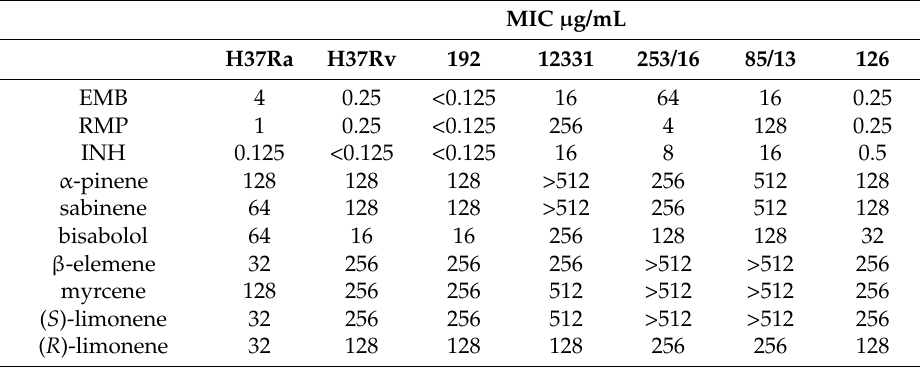
Table 2. The minimal inhibitory concentration values (MIC) obtained for compounds tested separately.